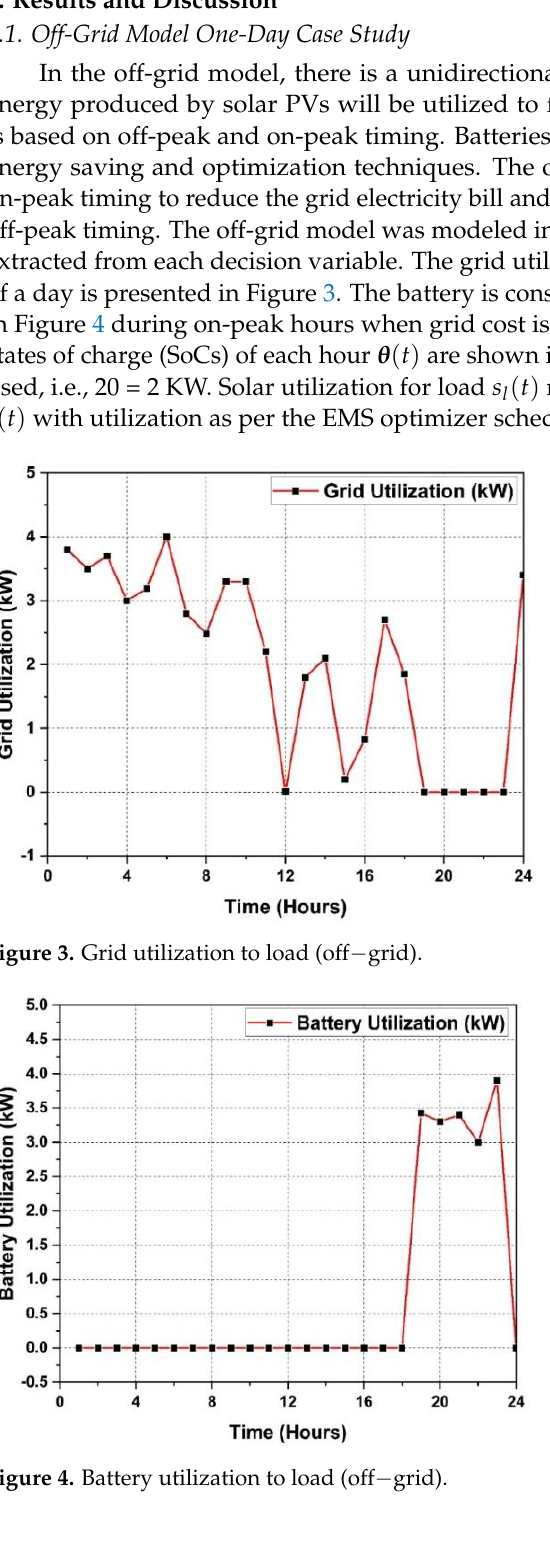
Figure 5. Battery states of charge (SoCs) in off−grid . Figure 6. Solar total generation and utilization (off−grid) . Load is directly fed through the EMS which decides the source path which needs to be triggered for the fulfillment of the load demand. A detailed analysis of total load and resource utilization in every hour is shown in Figure 7 for the off-grid model.